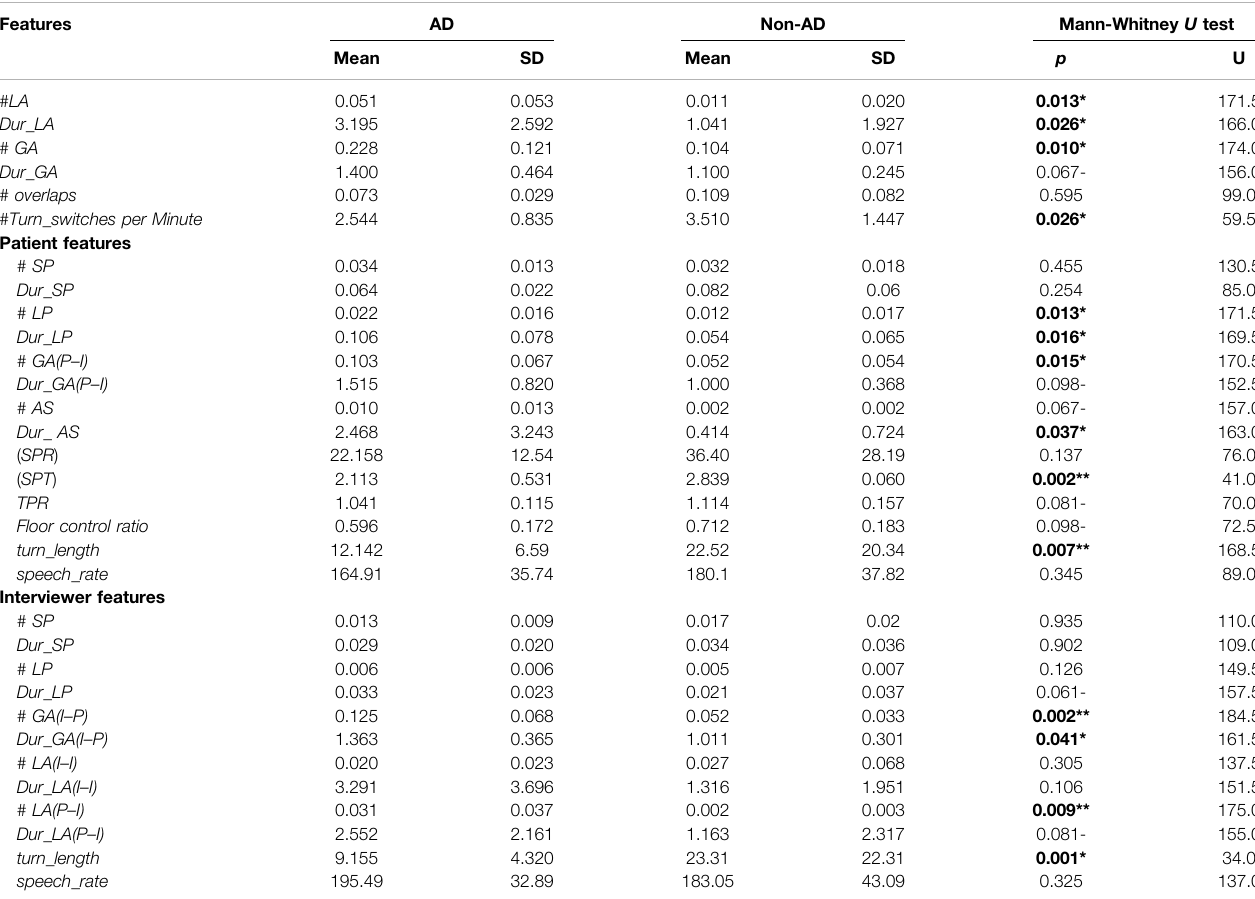
TABLE 6| Descriptivestatistics(mean,SD)and statisticalsigni fi canceforourinteractionalfeatureset.Wereport p valuesobtainedfromMann-Whitney Utestsagainst anull hypothesis with no differences in distributions of these interactions on AD. ** denotes highly signi fi cant at p < 0 . 01; * denotes signi fi cance at; - shows a trend toward signi fi cance at p < 0 . 1.